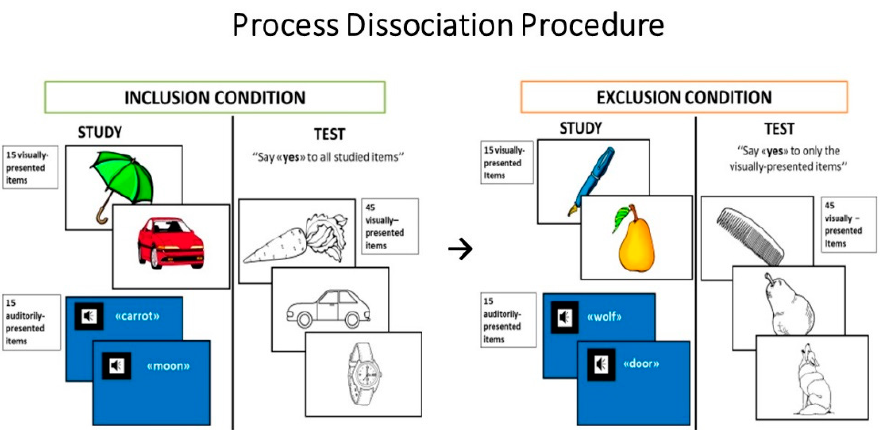
Figure 1. Examples of items in the Process Dissociation Procedure. Two recognition memory tests were given: one with inclusion, the other with exclusion instructions in the test phase. Although the study phase was identical, instructions differed for the test phases of the two conditions. Each study phase consisted of two blocks of stimuli: one set of 15 colored drawings and a set of 15 words spoken aloud by the examiner. During the test phase (immediately after the study phase), the participants were shown a set of 45 black-and-white line drawings (corresponding to 30 studied and 15 unstudied items) in random order. In the inclusion condition, participants are instructed to recognize as “old” all previously presented items, regardless of the list on which they had seen them, and to reject the novel items. In the exclusion condition, participants are instructed to recognize as “old” only the items presented visually, and to reject those presented in the other list as well as the novel items.